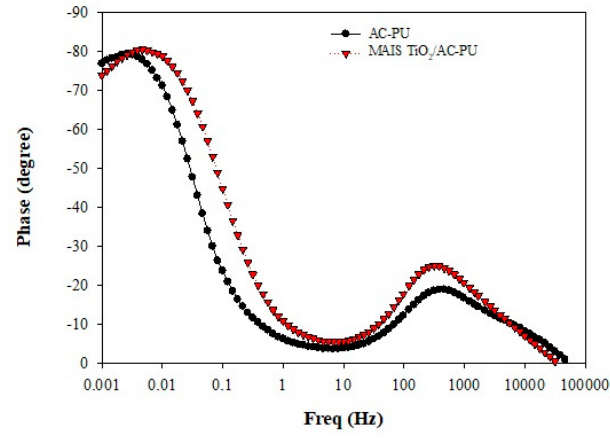
Figure 4. Bode plots for the electrodes.